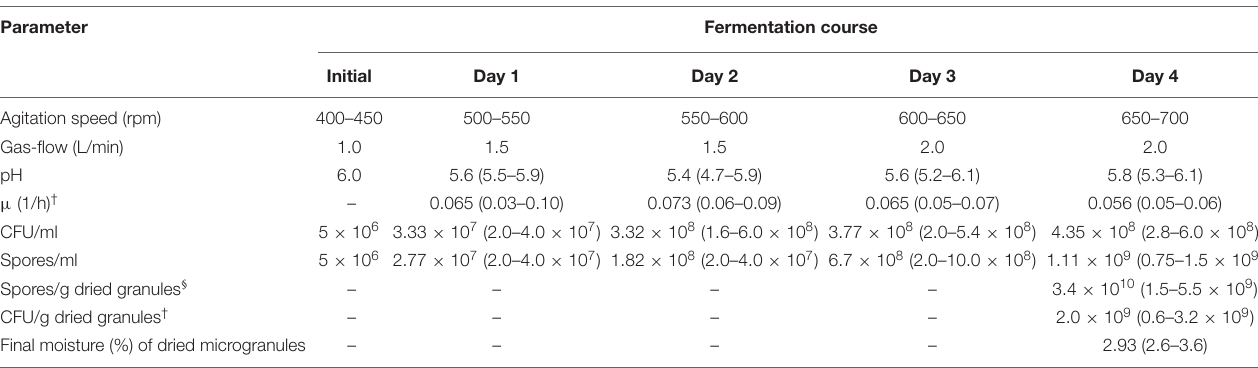
TABLE 2 | Submerged liquid fermentation parameters during C. rosea (strain CMAA1284) growth in a 3-L benchtop bioreactor across six independent batches (constant temperature set to 28 ◦ C).